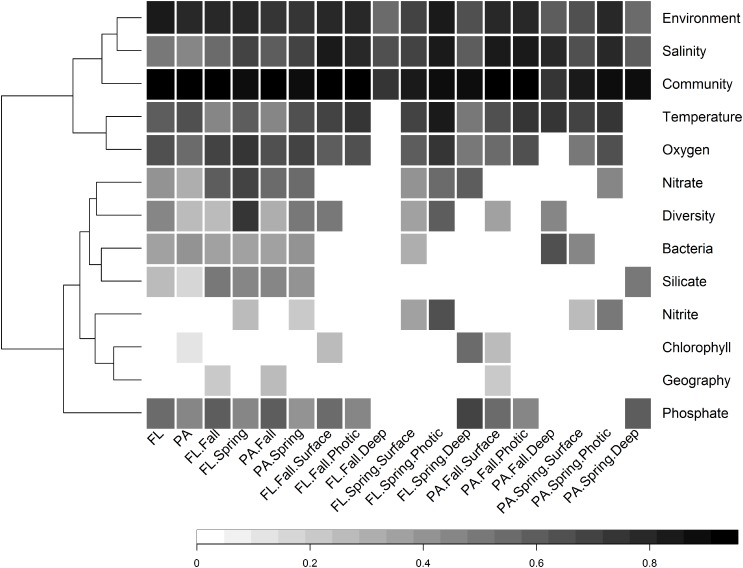
Heatmap of significant Partial Mantel correlation (Spearman’s) between pairwise Bray–Curtis similarity between samples and either pairwise geographic distance between sites, or pairwise environmental dissimilarity between samples, conducted on different subsets of samples. Every Partial Mantel test controlled for the effect of geographic distance between sites. The tests concerning the significance of geographic distance controlled for the environmental distance between sites as determined by the following non-collinear variables: temperature, salinity, oxygen, nitrate, ammonium, and nitrite. Only results that were highly significant (p < 0.001) are shown, while non-significant correlations are left blank. The community variable refers to the correlation between the Bray–Curtis community similarity of FL and PA size fractions from the same subset of samples, e.g., fall, or fall photic.